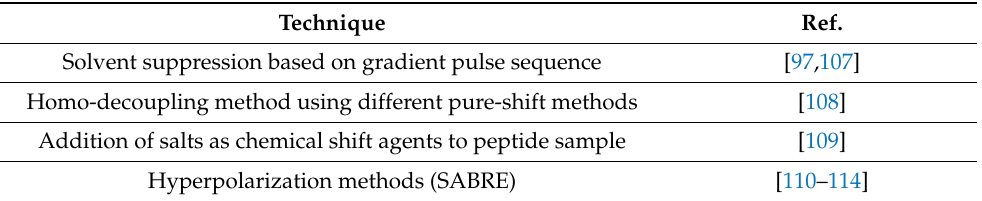
Table 7. Techniques used to improve the sensitivity and resolution of benchtop NMR spectroscopy.